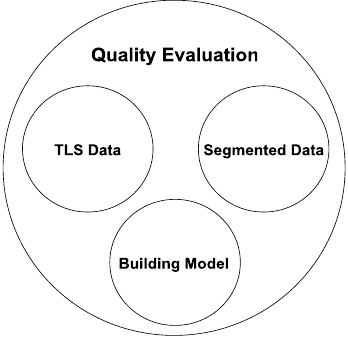
Figure 3: Diagram of quality evaluation